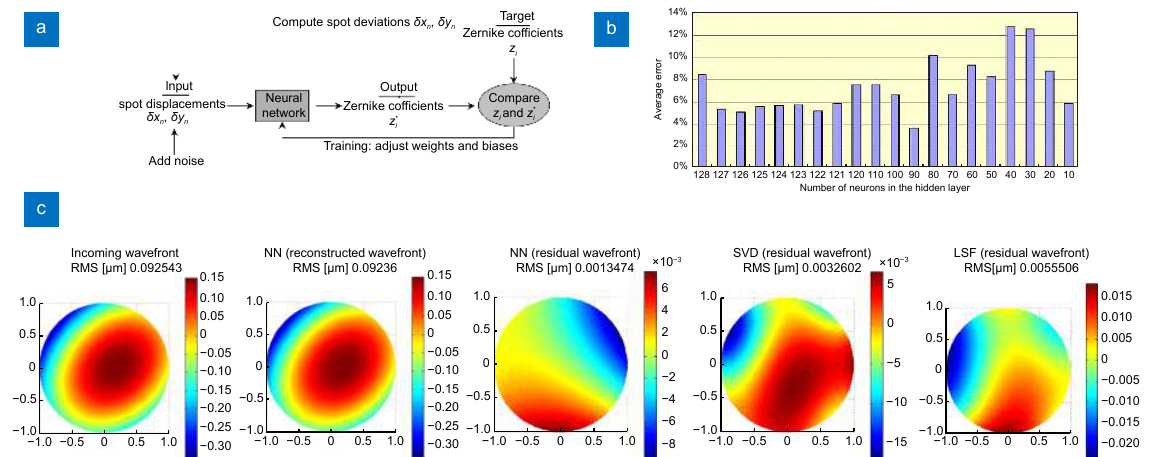
Fig. 3 | ( a ) The training algorithm of the ANN where displacements of the spots are taken as the inputs while the Zernike coefficients as outputs. To make the network more insensitive to the noise in the spot patterns, the training is also performed on noisy patterns. The noise added to the spot displacements follows Gaussian distribution. ( b ) The average reconstructed errors of ANNs with different number of neurons in the hidden layer shows that hidden layer with 90 neurons performs best. ( c ) Comparison of residual errors of LSF, SVD and ANN algorithms. Figure repro- duced from ref. 71 , Optical Society of